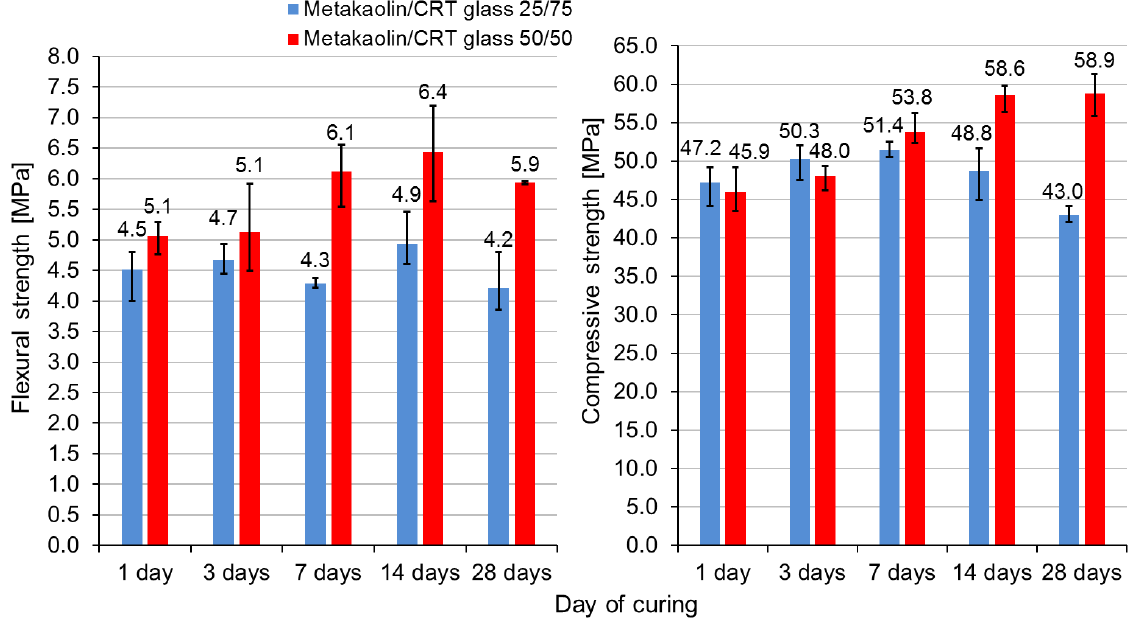
Figure 7. Flexural and compressive strengths of geopolymer cured for 1, 3, 7, 14, and 28 days.